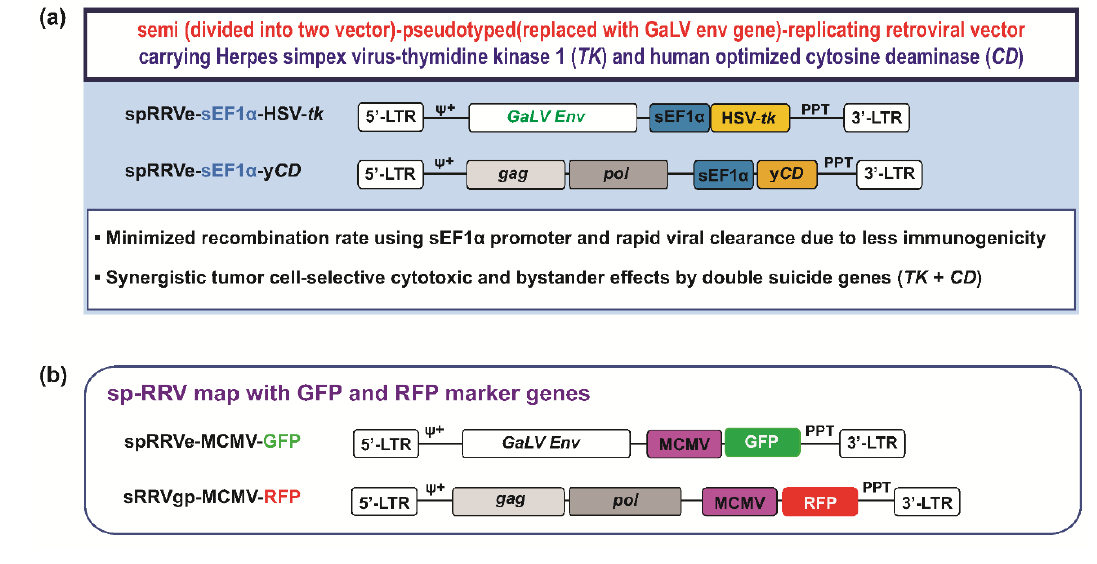
Figure 1. Schematic representation of a novel double-enhanced suicide gene delivery system using a semi-and pseudotyped-retroviral replicating vector (sp-RRV) system based on a gibbon ape leukemia virus (GaLV) carrying herpes simplex virus thymidine kinase (HSV- tk ) and human codon-optimized yeast cytosine deaminase (y CD ) for the treatment of glioblastoma. ( a ) A diagram illustrating spRRVe-short Elongation factor1-alpha (sEF1 α )- TK and sRRVgp-sEF1 α - CD systems. The sRRVgp vector contains the murine leukemia virus (MuLV) gag - pol coding sequence and the spRRVe vector was prepared by removing most of the MuLV gag - pol region and inserting the GaLV- env coding sequence. ( b ) A schematic vector diagram illustrating the structures of sp-RRV genome labeled with green fluorescence protein (GFP) (spRRVe-murine cytomegalovirus (MCMV)-GFP) and red fluorescence protein (RFP) (sRRVgp-MCMV-RFP) for the evaluation of virus infectivity. LTR: long terminal repeat.